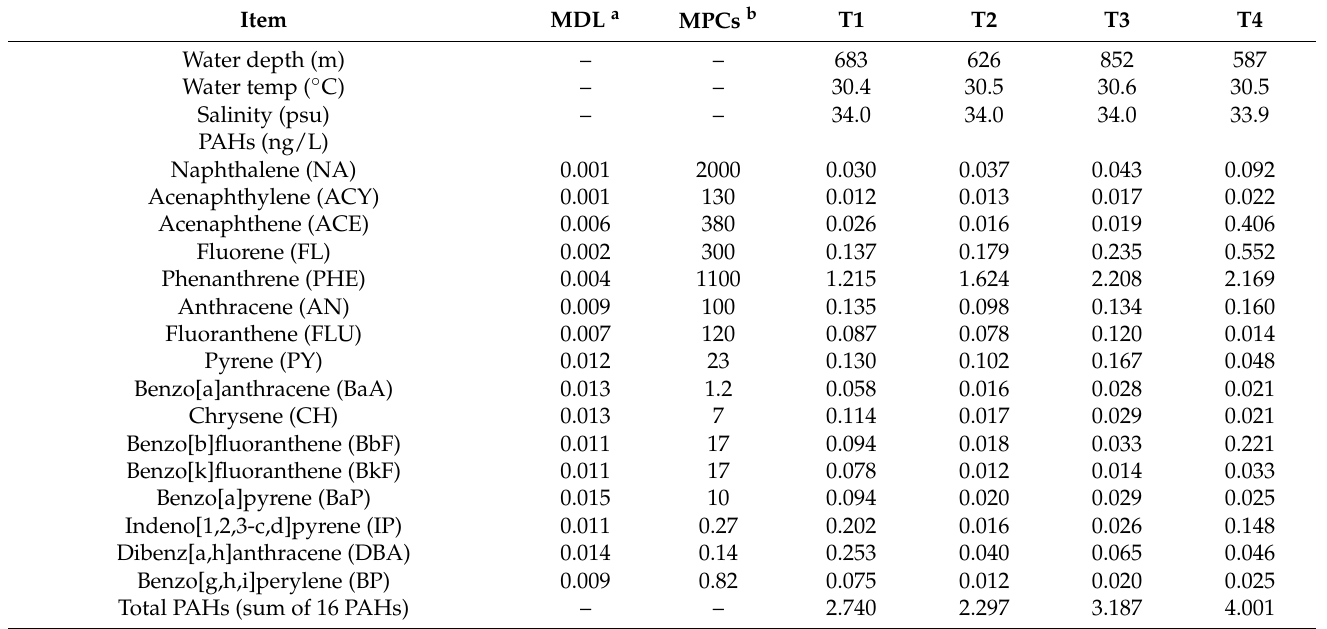
Table 4. Concentrations of dissolved polycyclic aromatic hydrocarbons in seawater collected offshore of southern